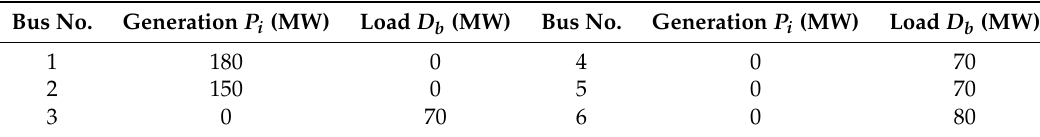
Table 2. Generation and load data for the 6-bus